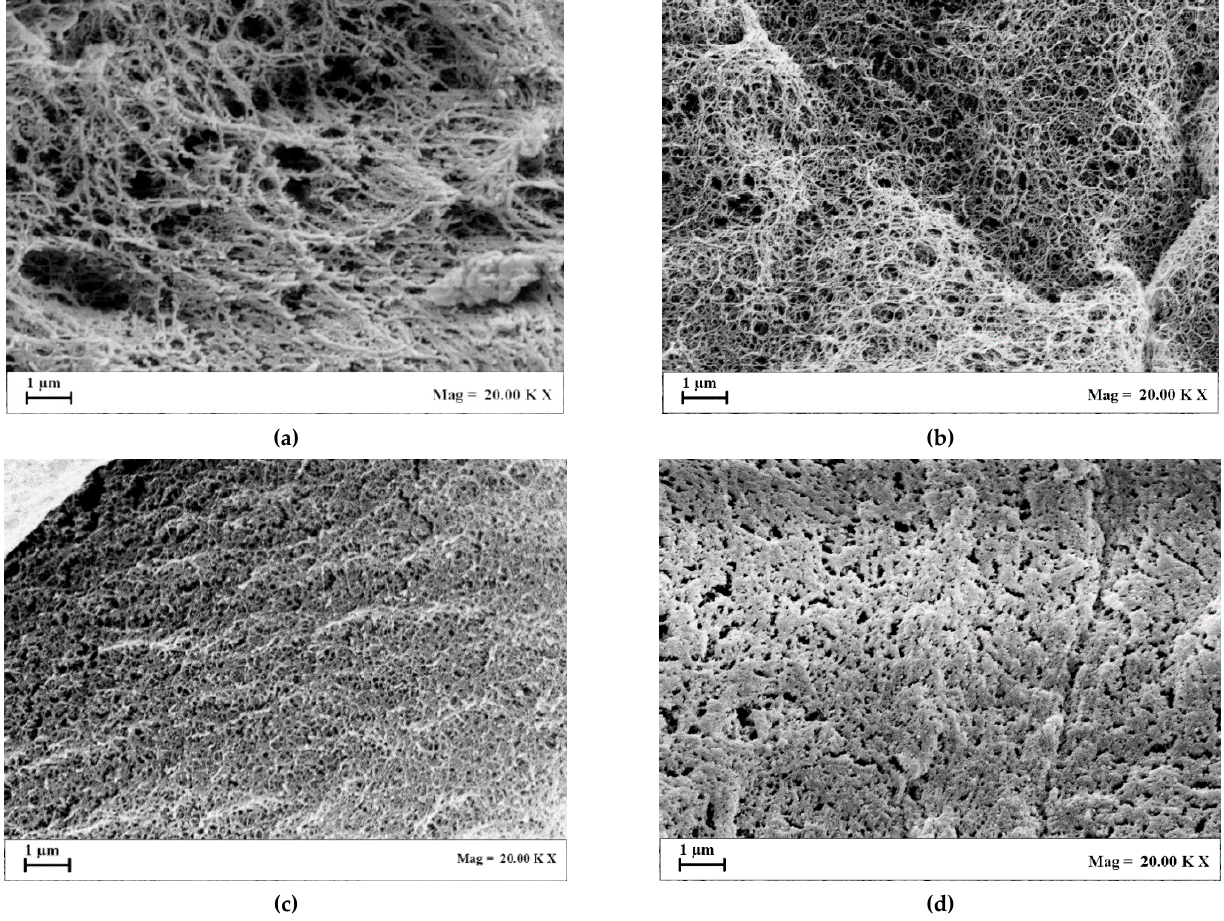
Figure 5. SEM images of aerogels section: ( a ) 1 wt% agarose; ( b ) 3 wt% agarose; ( c ) 5 wt% agarose; ( d ) 8 wt% agarose.